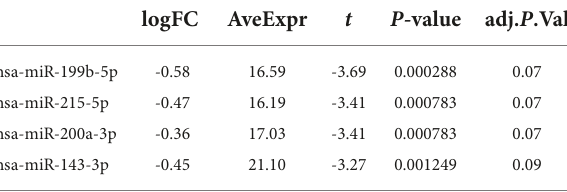
low, medium, and high expressed level for Kaplan–Meier curve plotting using R package survminer (v0.4.9)